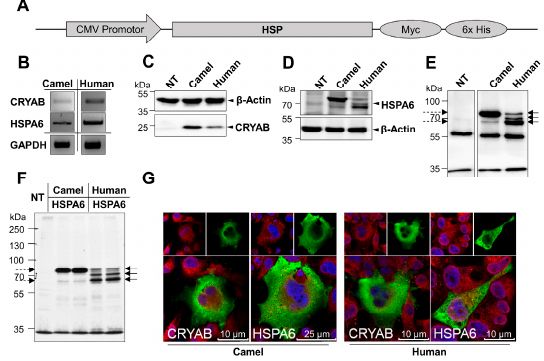
Figure 2. Cloning, expression and localization of Camelus dromedarius and human HSPs: ( A ) Schematic diagram showing the general design of cloned camel and human HSPs. Camel and human CRYAB or HSPA6 are Myc-tagged in their C-terminal and their expression is controlled by cytomegalovirus (CMV) promotor; ( B ) The upper and middle panels show Camelus dromedarius and human CRYAB as well as HSPA6 amplified cDNA products with sizes of 1932 bp and 528 bp, respectively. Amplified GAPDH cDNA product in the lower panel was used as control for RNA isolation and cDNA synthesis; ( C , D ) Western blot analysis of proteins analyzed by SDS-PAGE on 9% slab gels showing expression of camel and human CRYAB and HSPA6 respectively after transfection in COS-1 cells. Camel and human CRYAB were detected as protein bands of an apparent molecular weight of 25 kDa while camel and human HSPA6 specific bands run at around 70 kDa on the gel. Non-transfected COS-1 cells (NT). Actin, a house keeping protein was used as a loading control; ( E ) Immunoprecipitation of camel and human HSPA6 showing different isoforms between the two HSPs upon expression in COS-1 cells. As illustrated, camel HSPA6 (dashed arrows) has two isoforms, a highly expressed high molecular weight form and a lower molecular weight faint one while the human HSPA6 (continuous arrows) reveals three protein bands with the lowest being the most expressed isoform; ( F ) Immunoprecipitation of 35 S labeled Myc tagged camel and human HSPA6 confirms the results in C; ( G ) Laser confocal microscopy reveals camel and human HSPA6 and CRYAB in the cytosol of transfected COS-1 cells. HSP (green) was visualized together with the cell nucleus (blue) and calnexin (red) as an ER marker. Scale bars: 25 μ m or 10 μ m.